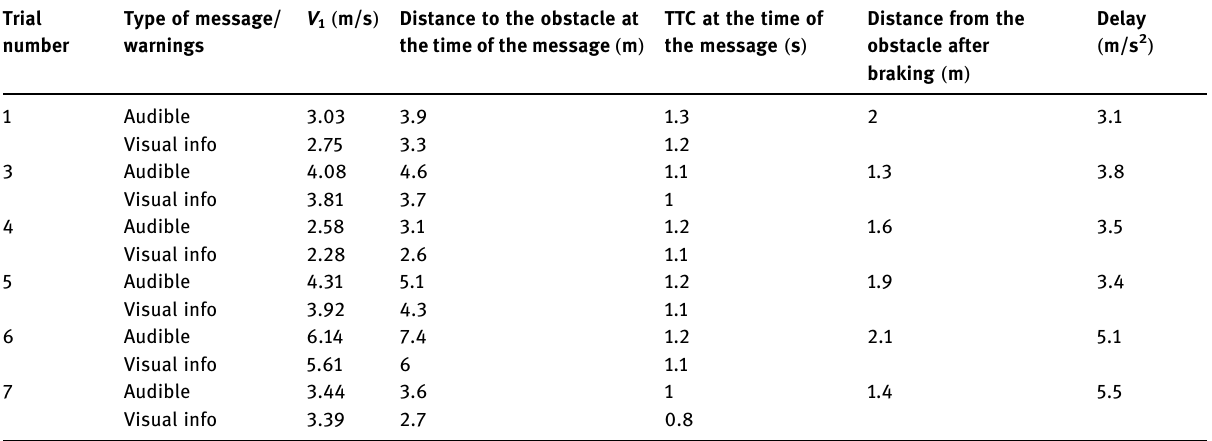
Table 9: Summary of results for trials with a low value for the braking rate Trial